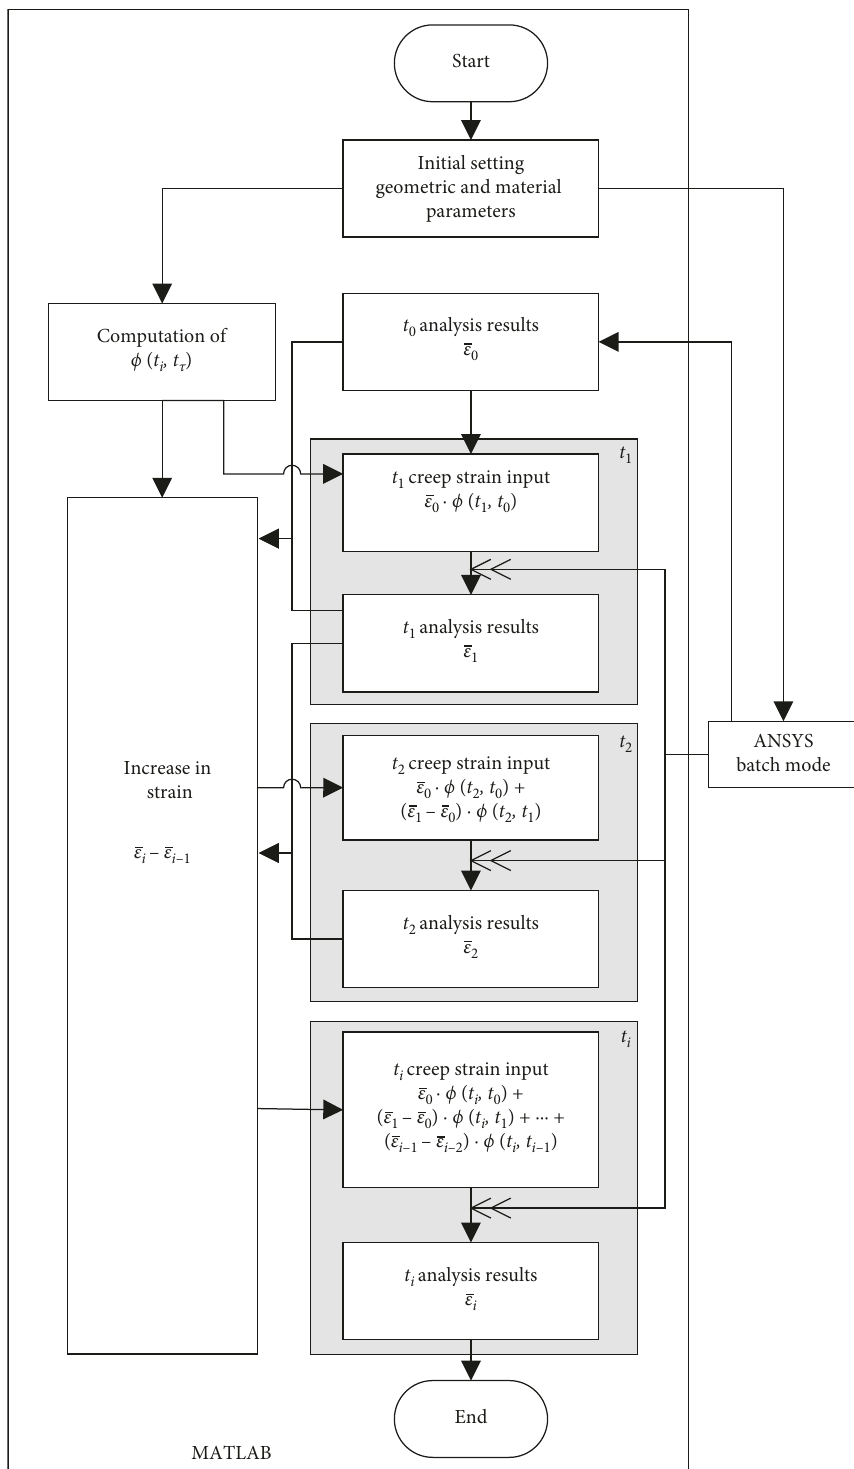
Figure 1: Flow chart of creep